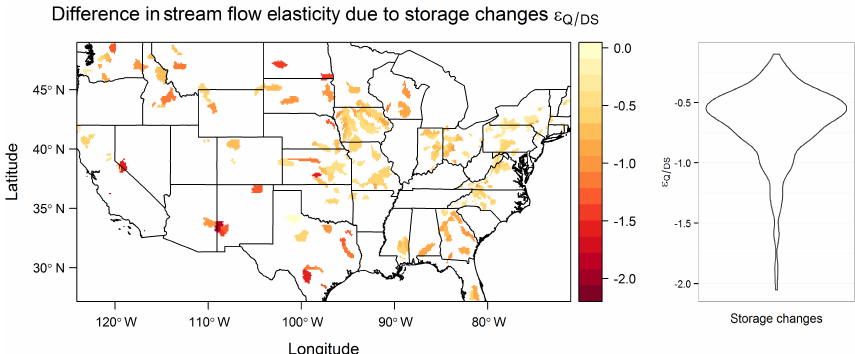
Figure 6. Annual streamflow elasticity due to change in storage (dimensionless) as derived from trivariate equation. On the left side, a violin plot shows the distribution of elasticity due to storage change.